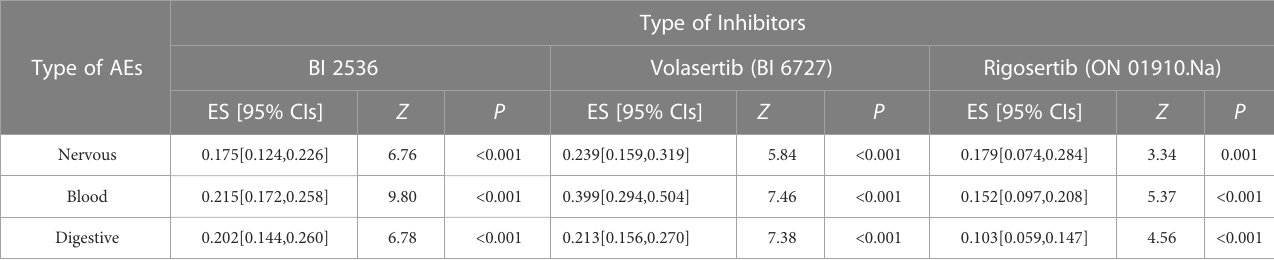
TABLE 6 The incidence of AEs in the overall estimate with different inhibitor types.